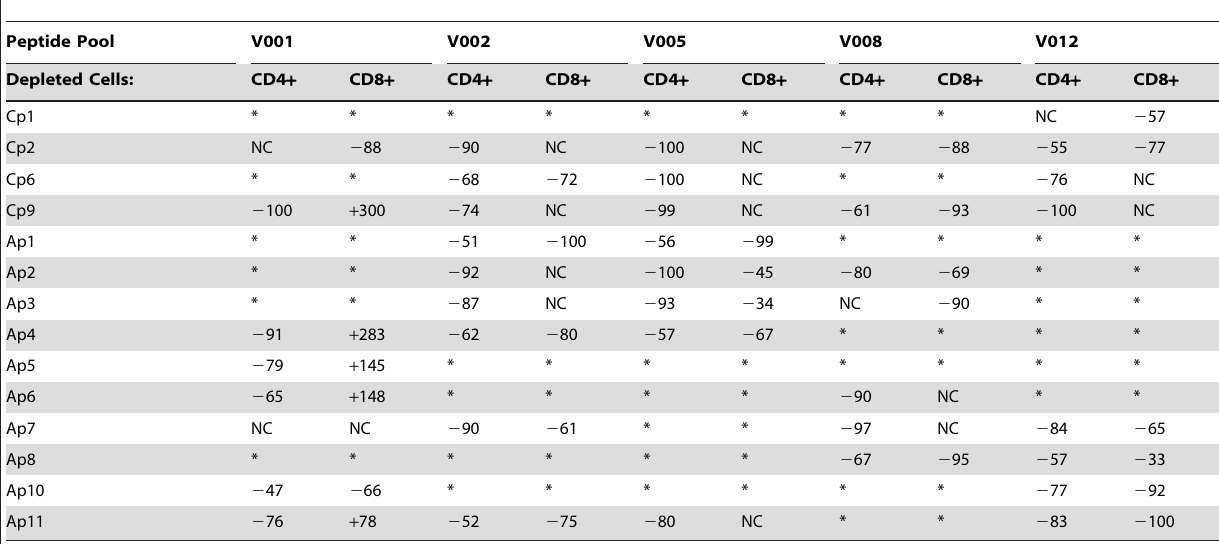
IFN- c production by ELISpot assay was measured with and without depletion of either CD4 + or CD8 + T cell populations and is expressed as percent change in spot forming cells with depletion. A negative value indicated IFN- c decreased by the indicated percentage after depletion, and a positive value indicated IFN- c increased after depletion. All peptide pools tested in ELISpot depletion studies met criteria for positive in the absence of depletion (Figures 1 and 2). Any decrease or increase in ELISpot responses of $ 25% following depletion was scored as positive and a number is provided in the table, while changes , 25% were scored as no change (NC).